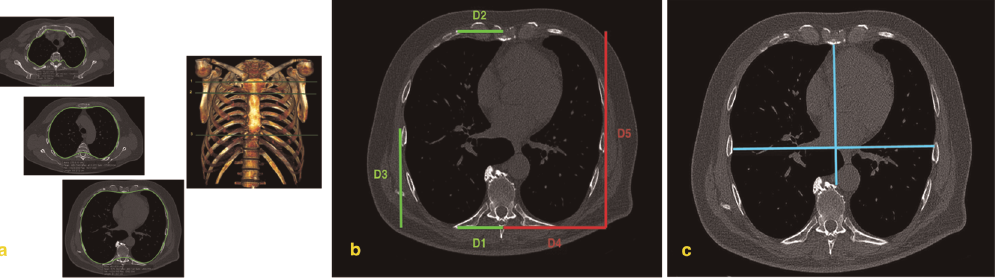
Figure 1. Examples illustrating the rib cage measurements. ( A ) Rib cage measurements were taken at three anatomical levels as follows: 1) sternal articulation of the first rib (upper level), 2) manubrio-sternal joint (middle level), and 3) xiphisternal joint (lower level). The areas burdens were manually traced by using a freehand electronic caliper (green line) along the inner surface of the rib cage. ( B ) For each hemithorax, several rib cage diameters (D) were measured by using the electronic caliper. To better display them, the diameters are shown separately. On the left side: D1 (from the most dorsal point of the rib and the apex of the vertebral spinous process); D2 (from the most ventral point of the rib cage to the sternal midpoint); D3 (from the most lateral point of the rib cage to the most lateral point of D4). On the right side: D4 (from the apex of vertebral spinous process to the lowest point of D3); D5 (from the most ventral point to the most dorsal point of the rib cage) diameters. ( C ) Haller’s index was obtained by assessing the ratio between the mid-antero-posterior diameter (from the inner surface of the sternum to ventral surface of the vertebral body) and the global transverse diameter (from the most external mid-point of the rib of one side to the opposite one).